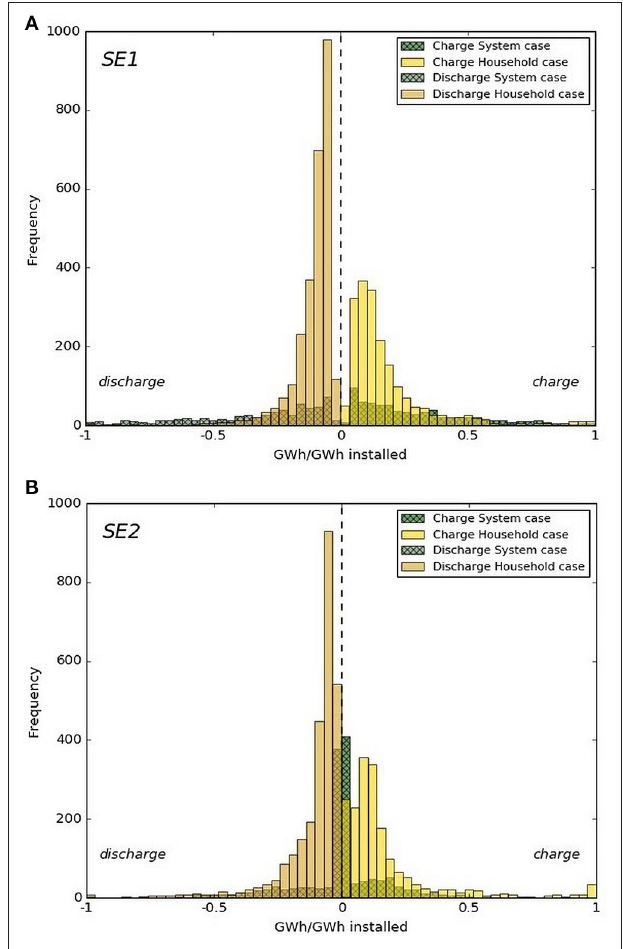
FIGURE 5 | Frequencies of charge and discharge events for the Household and System cases in southern Swedish regions SE1 (A) and SE2 (B) , as obtained from the modeling of the Green Policy scenario. (For the sake of clarity, charge/discharge events that are very low, i.e., in the range of − 0.03 to 0.03 GWh/GWh installed , have been